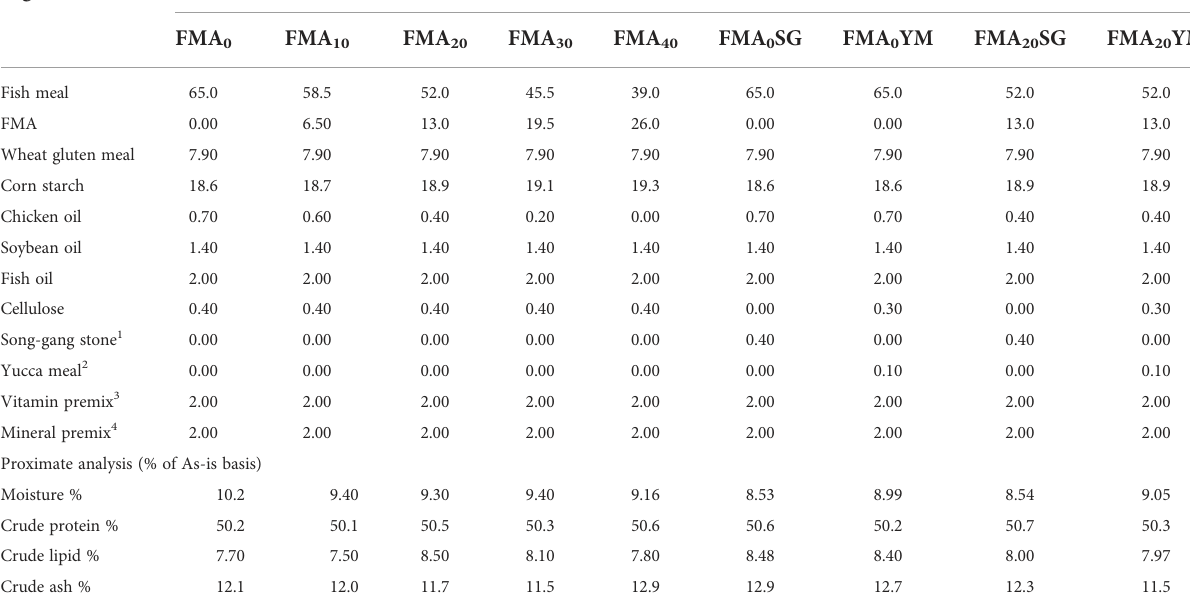
TABLE 1 Formulation and proximate composition of the experimental diets in juvenile Japanese